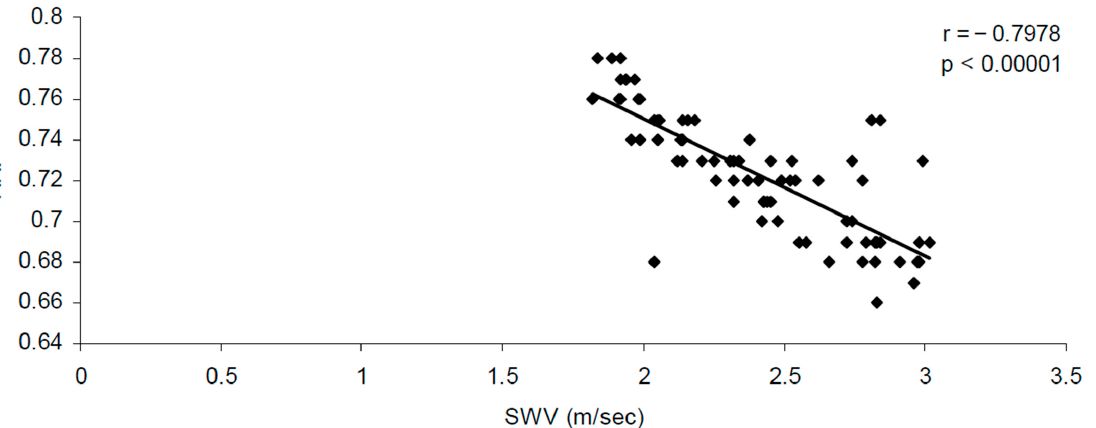
Figure 5. Correlations between SWV and